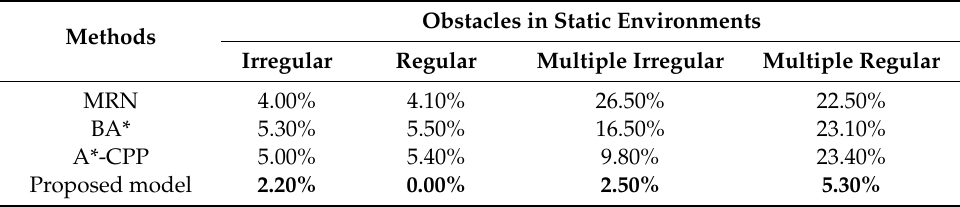
Table 3. The repetition rate in experimental result simulations in various environments.